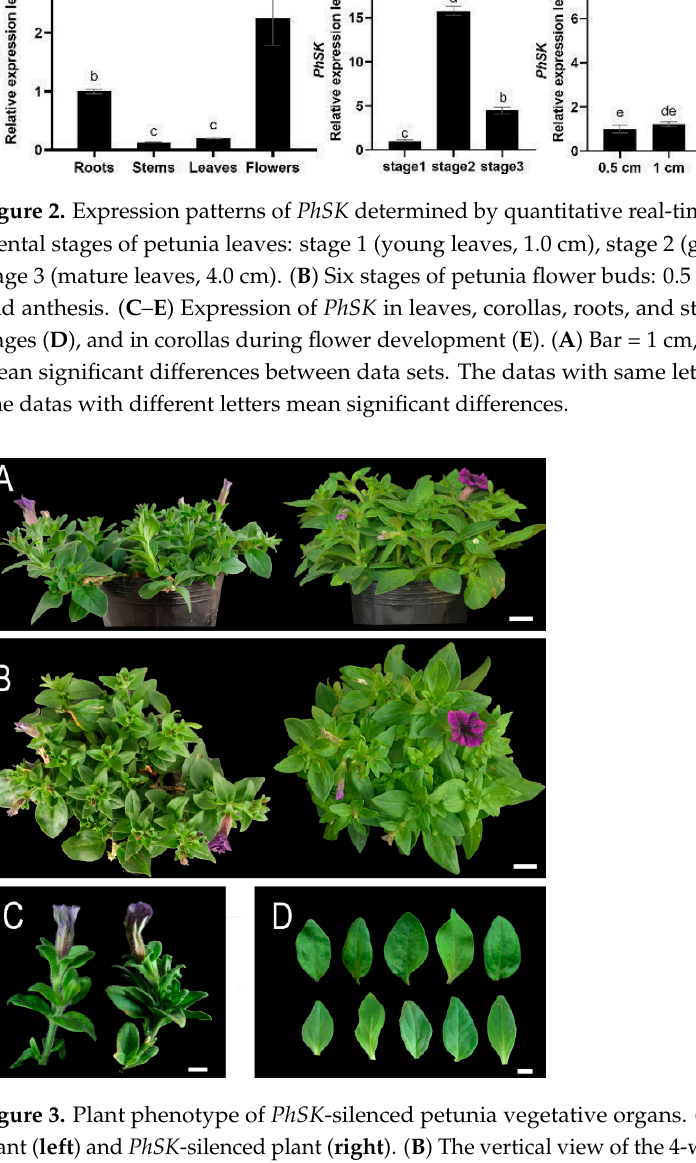
Figure 3. Plant phenotype of PhSK -silenced petunia vegetative organs. ( A ) Four-week-old control plant ( left ) and PhSK -silenced plant ( right ). ( B ) The vertical view of the 4-week-old control plant ( left ) and PhSK -silenced plant ( right ). ( C ) Internodes of the control plant ( left ) and PhSK -silenced